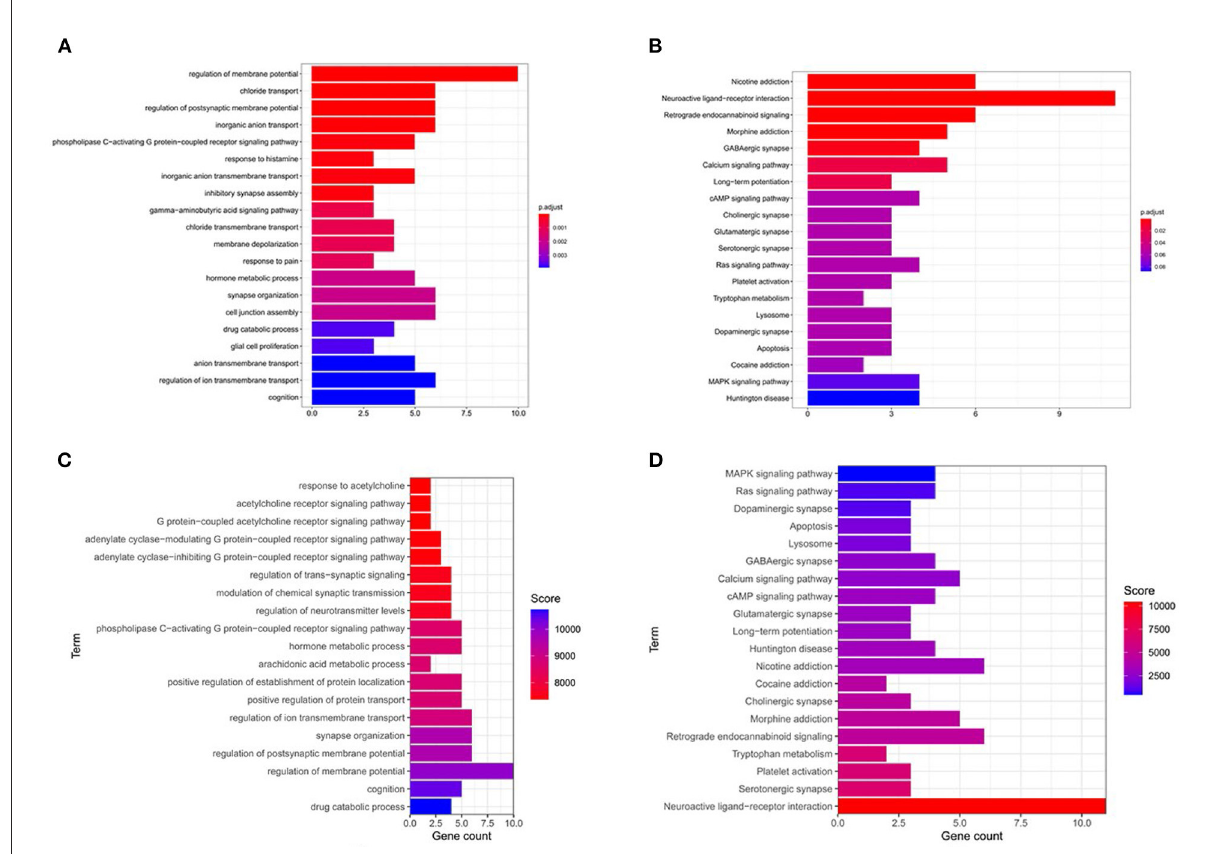
FIGURE4 GO-bp and KEGG enrichment results. (A,B) The enrichment results of GO-BP and KEGG before sorting. (C,D) The GO-BP and KEGG enrichment results after sequencing.